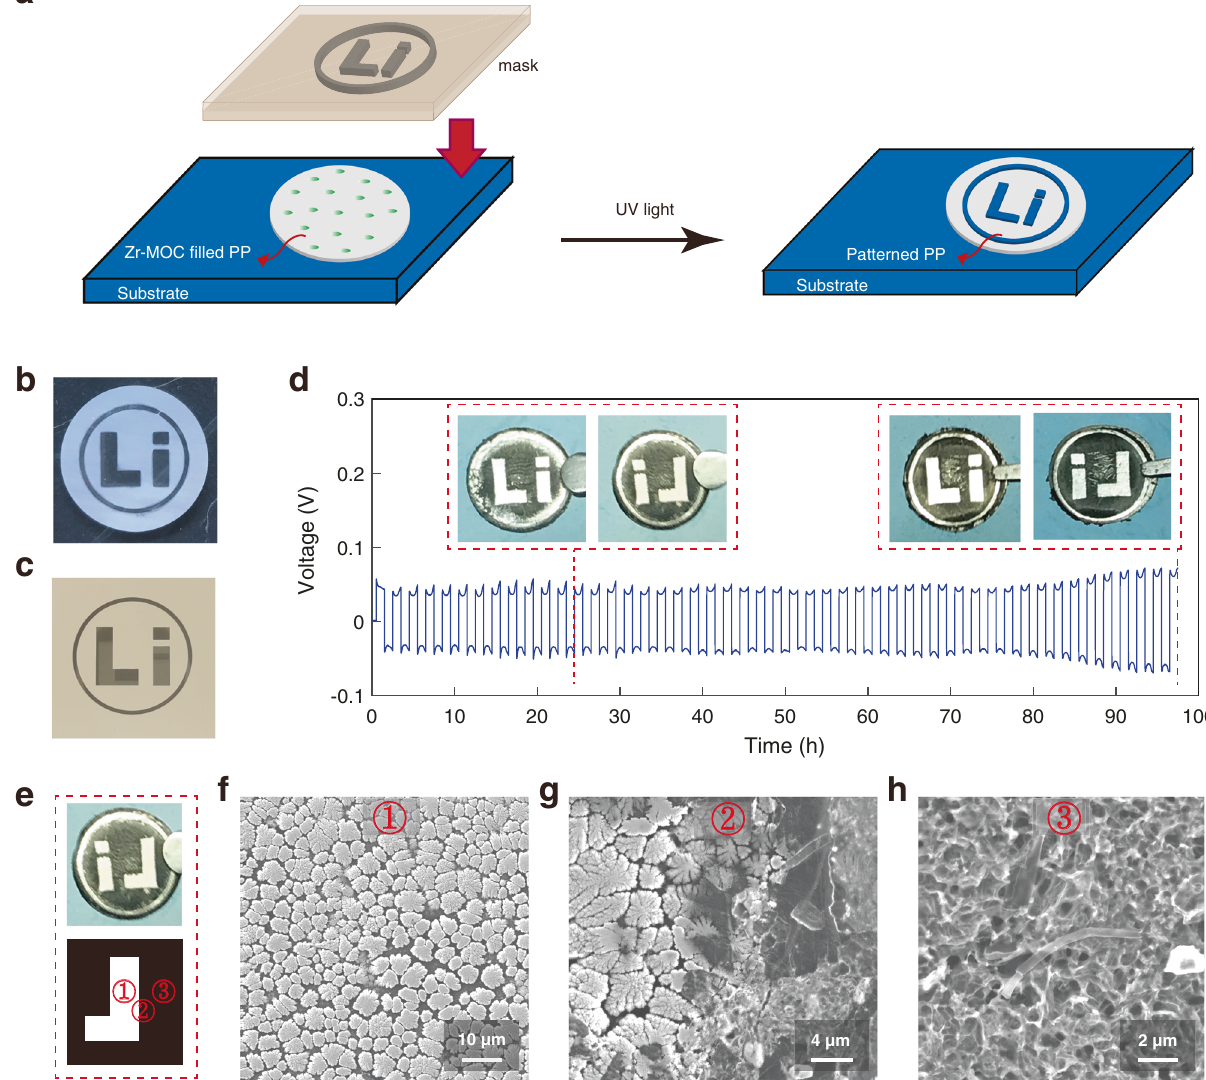
Fig. 3 Preparation of patterned Zr-MOCN@PP separator and the electrodeposition properties. a Schematic of the preparation process of the patterned separator. b , c The patterned separator and the photomask of “ Li ” shape, respectively. d Voltage vs. time pro fi le of symmetric lithium cell with a “ Li ” shape pattern separator at a fi xed current density of 1.0 mA cm − 2 , each half-cycle lasts 1 h. Insets showed the lithium metal electrodes after 24 h and 96 h stripping/plating cycles, respectively. e Lithium metal electrode after being cycled for 24 h and scheme of ‘ L ’ with different positions of ① , ② , ③ in the lithium metal above. f , g , h Top-view SEM images of the lithium metal electrode of ① , ② , ③